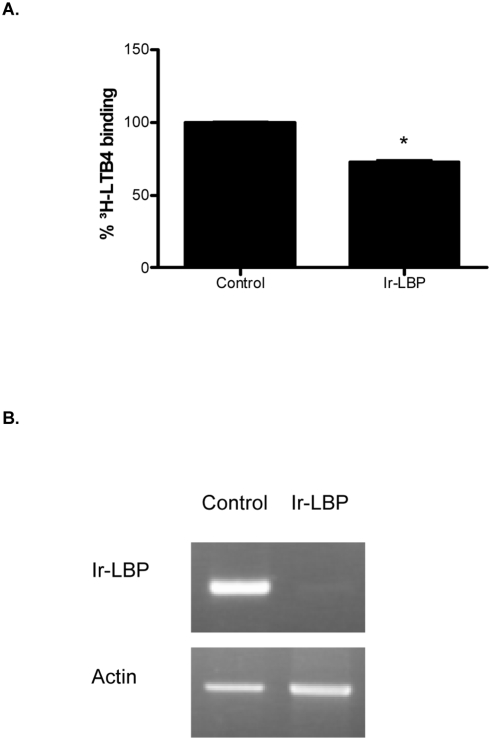
Ir-LBP knockdown in tick salivary glands.A) Eight pairs of salivary glands were incubated for 6 h with control or Ir-LBP siRNA. Five µg of salivary gland extracts were incubated with 2 nM of 3H-LTB4. B) RT-PCR analysis of RNA from control and Ir-LBP siRNA-treated salivary glands using Ir-LBP or actin gene-specific primers.